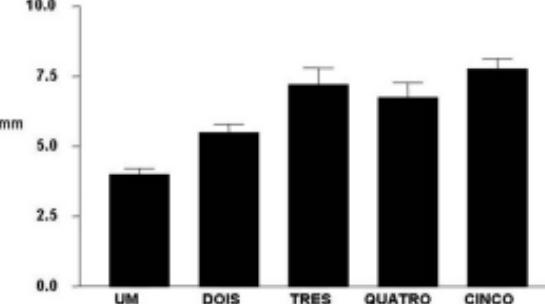
Fig. 3 - Medida da distância (em mm), entre o ânulo mitral e as artérias que o circundam em corações com dominância direita, nos cinco pontos